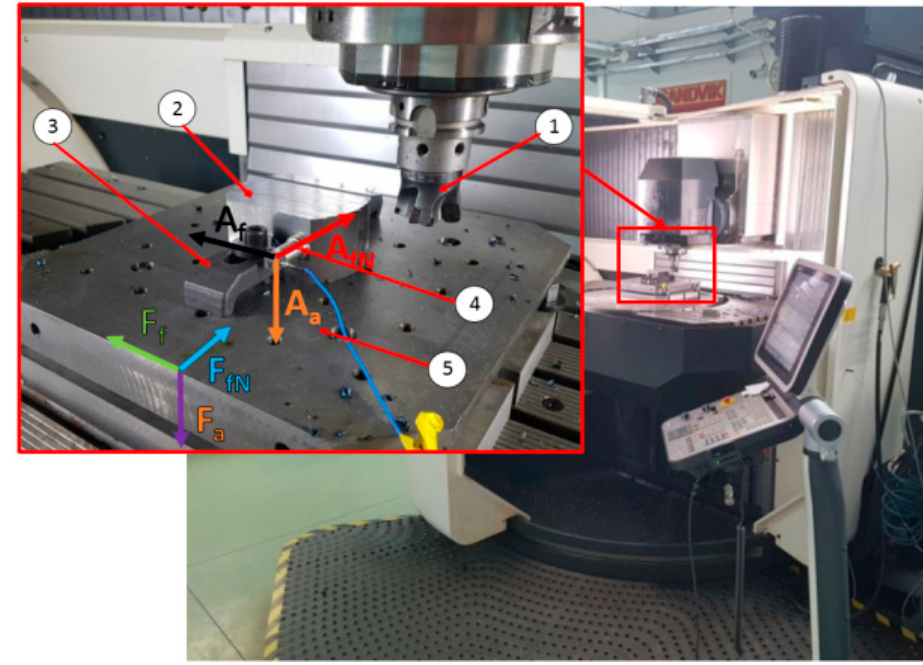
Figure 3. Test stand: 1—HF cutter, 2—milled part, 3—cranked clamp, 4 –vibration sensor, 5—cutting force components measuring